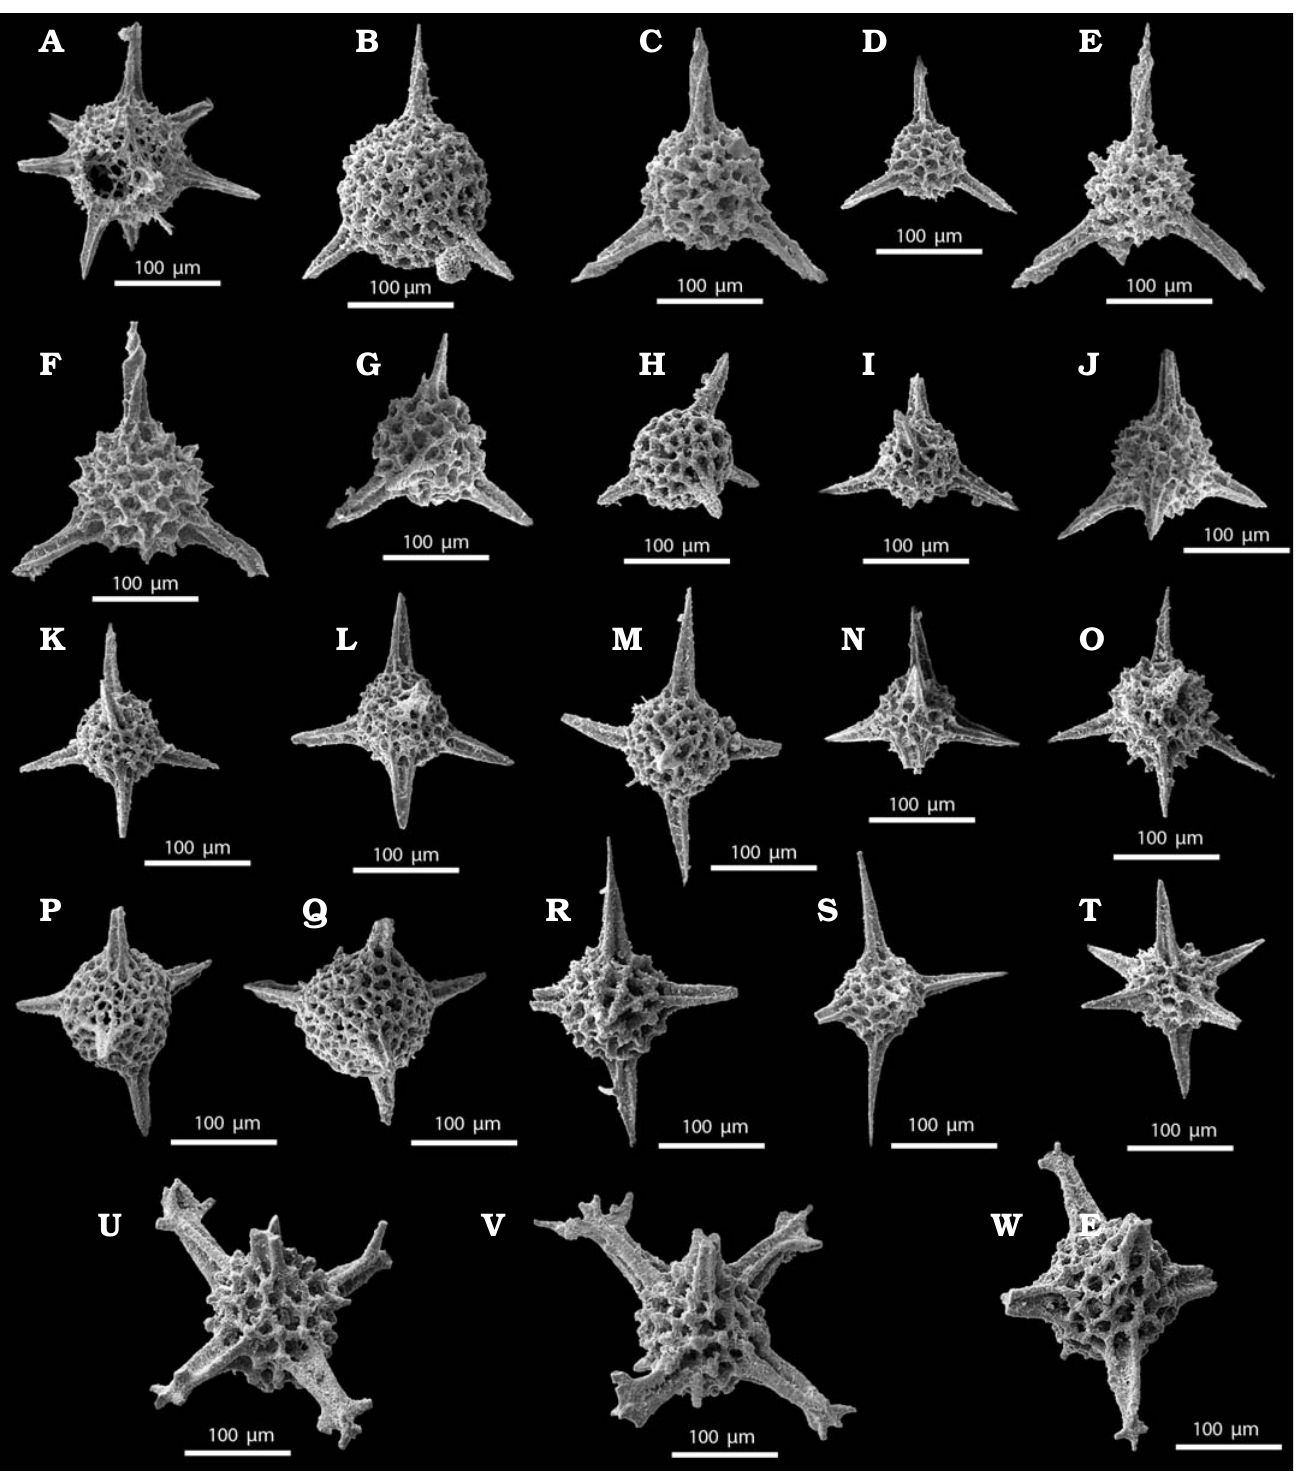
Fig. 6. Radiolarians from Mount Rettenstein, Austria, Pliensbachian, Early Jurassic. A . Empirea sp. 1, sample Rö416. B . Acaeniotylopsis